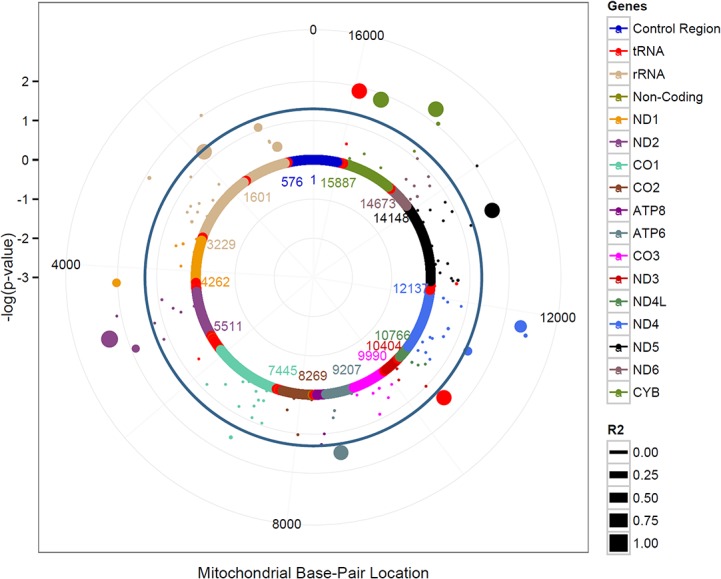
Mitochondrial solar plot for European Americans.From outside to inside, the three grey circles correspond to the P value of 10–3, 10–2and 10–1. The teal circle represents a p-value of 0.05. Each dot represents the mtSNP association with CRC color coded by mitochondrial gene. The size of each dot represents the correlation (R2) between mt4917 and other mtSNPs among European Americans.